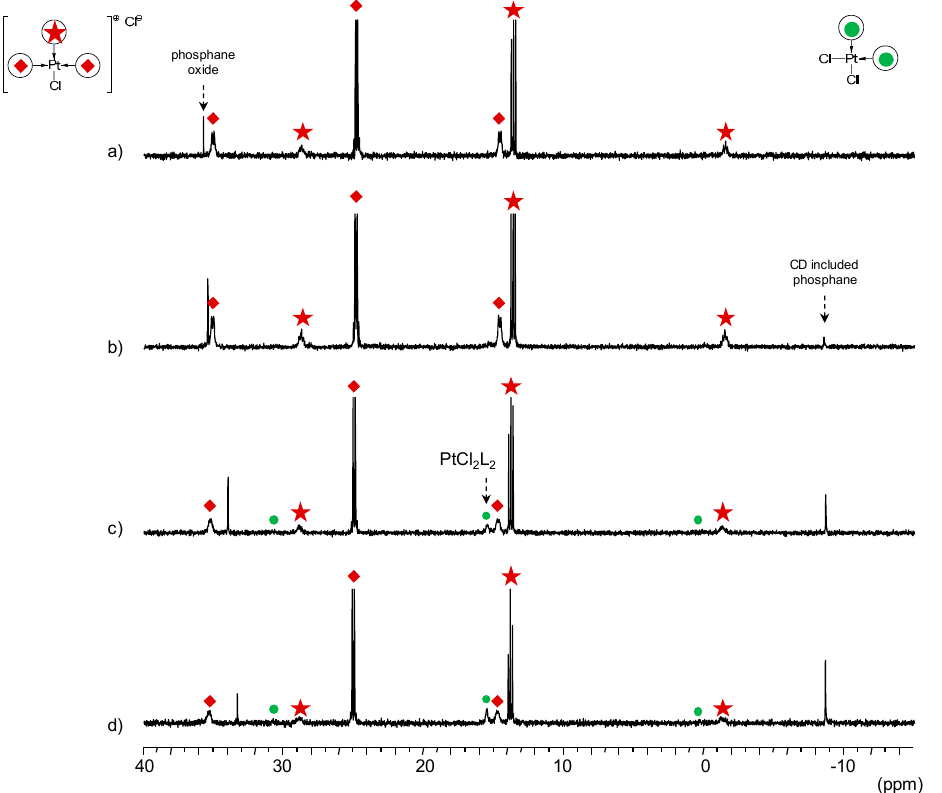
Figure 6. 31 P{ 1 H} NMR spectra of ( a ) [Pt(TPPTS) 3 Cl]Cl (10 mM); ( b ) +3 equiv. of RAME- β -CD toward Pt ( c ) +6 equiv. of RAME- β -CD and ( d ) +12 equiv. of RAME- β -CD at 25 °C in D 2 O.